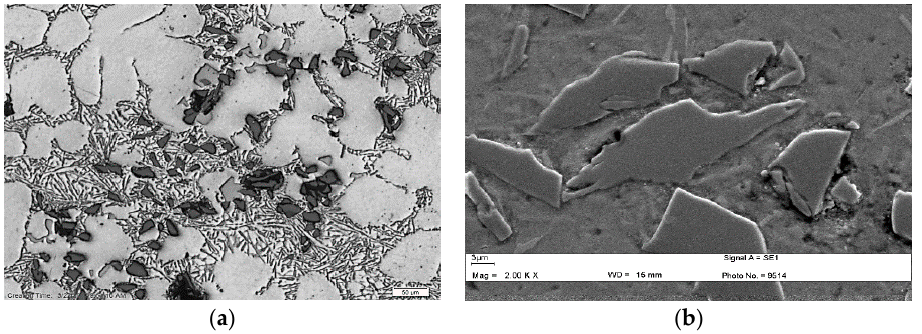
Figure 7. ( a ) Micrograph of mid-radius position of A356 / SiC feedstock (15%SiC-37 µ m), and ( b ) SEM image showing SiC particles embedded in the eutectic phase .